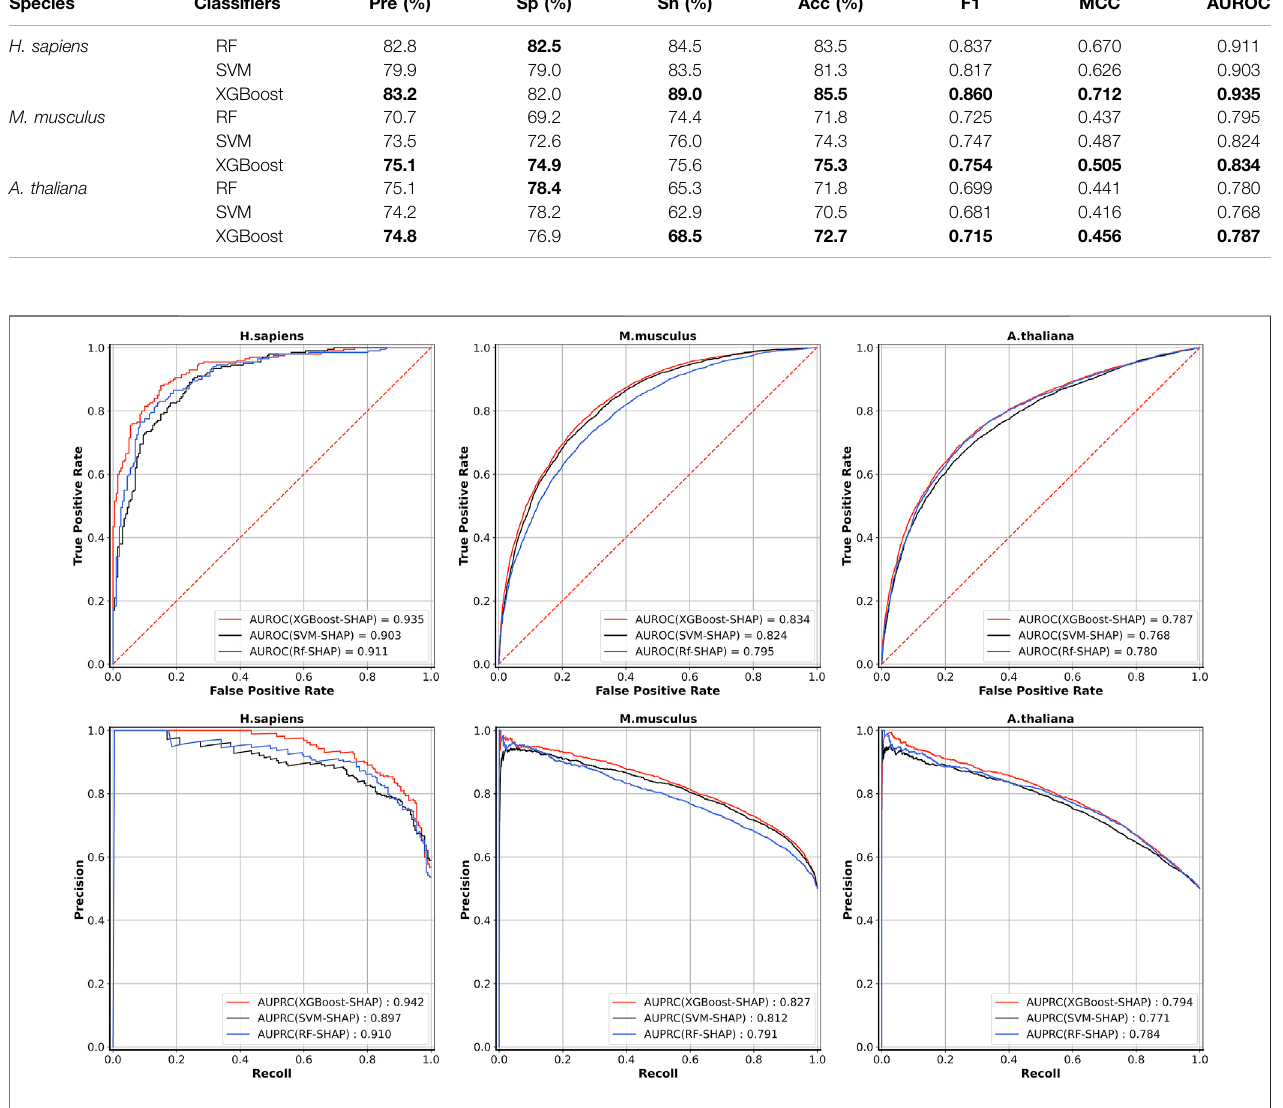
Frontiers in Genetics |